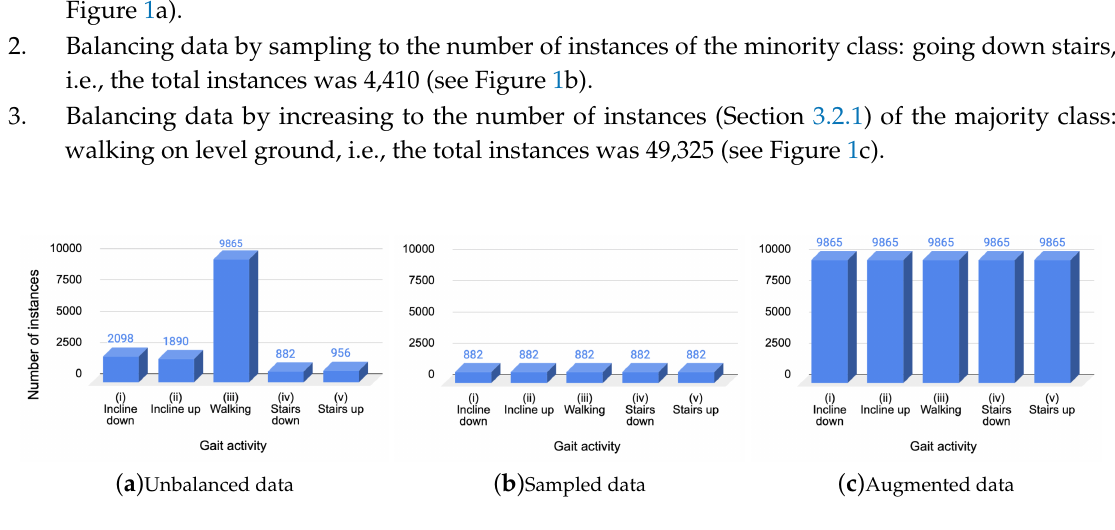
Figure 1. Data treatments: ( a ) original dataset; ( b ) randomly subsampled data from the original dataset; ( c ) augmented data using synthetic